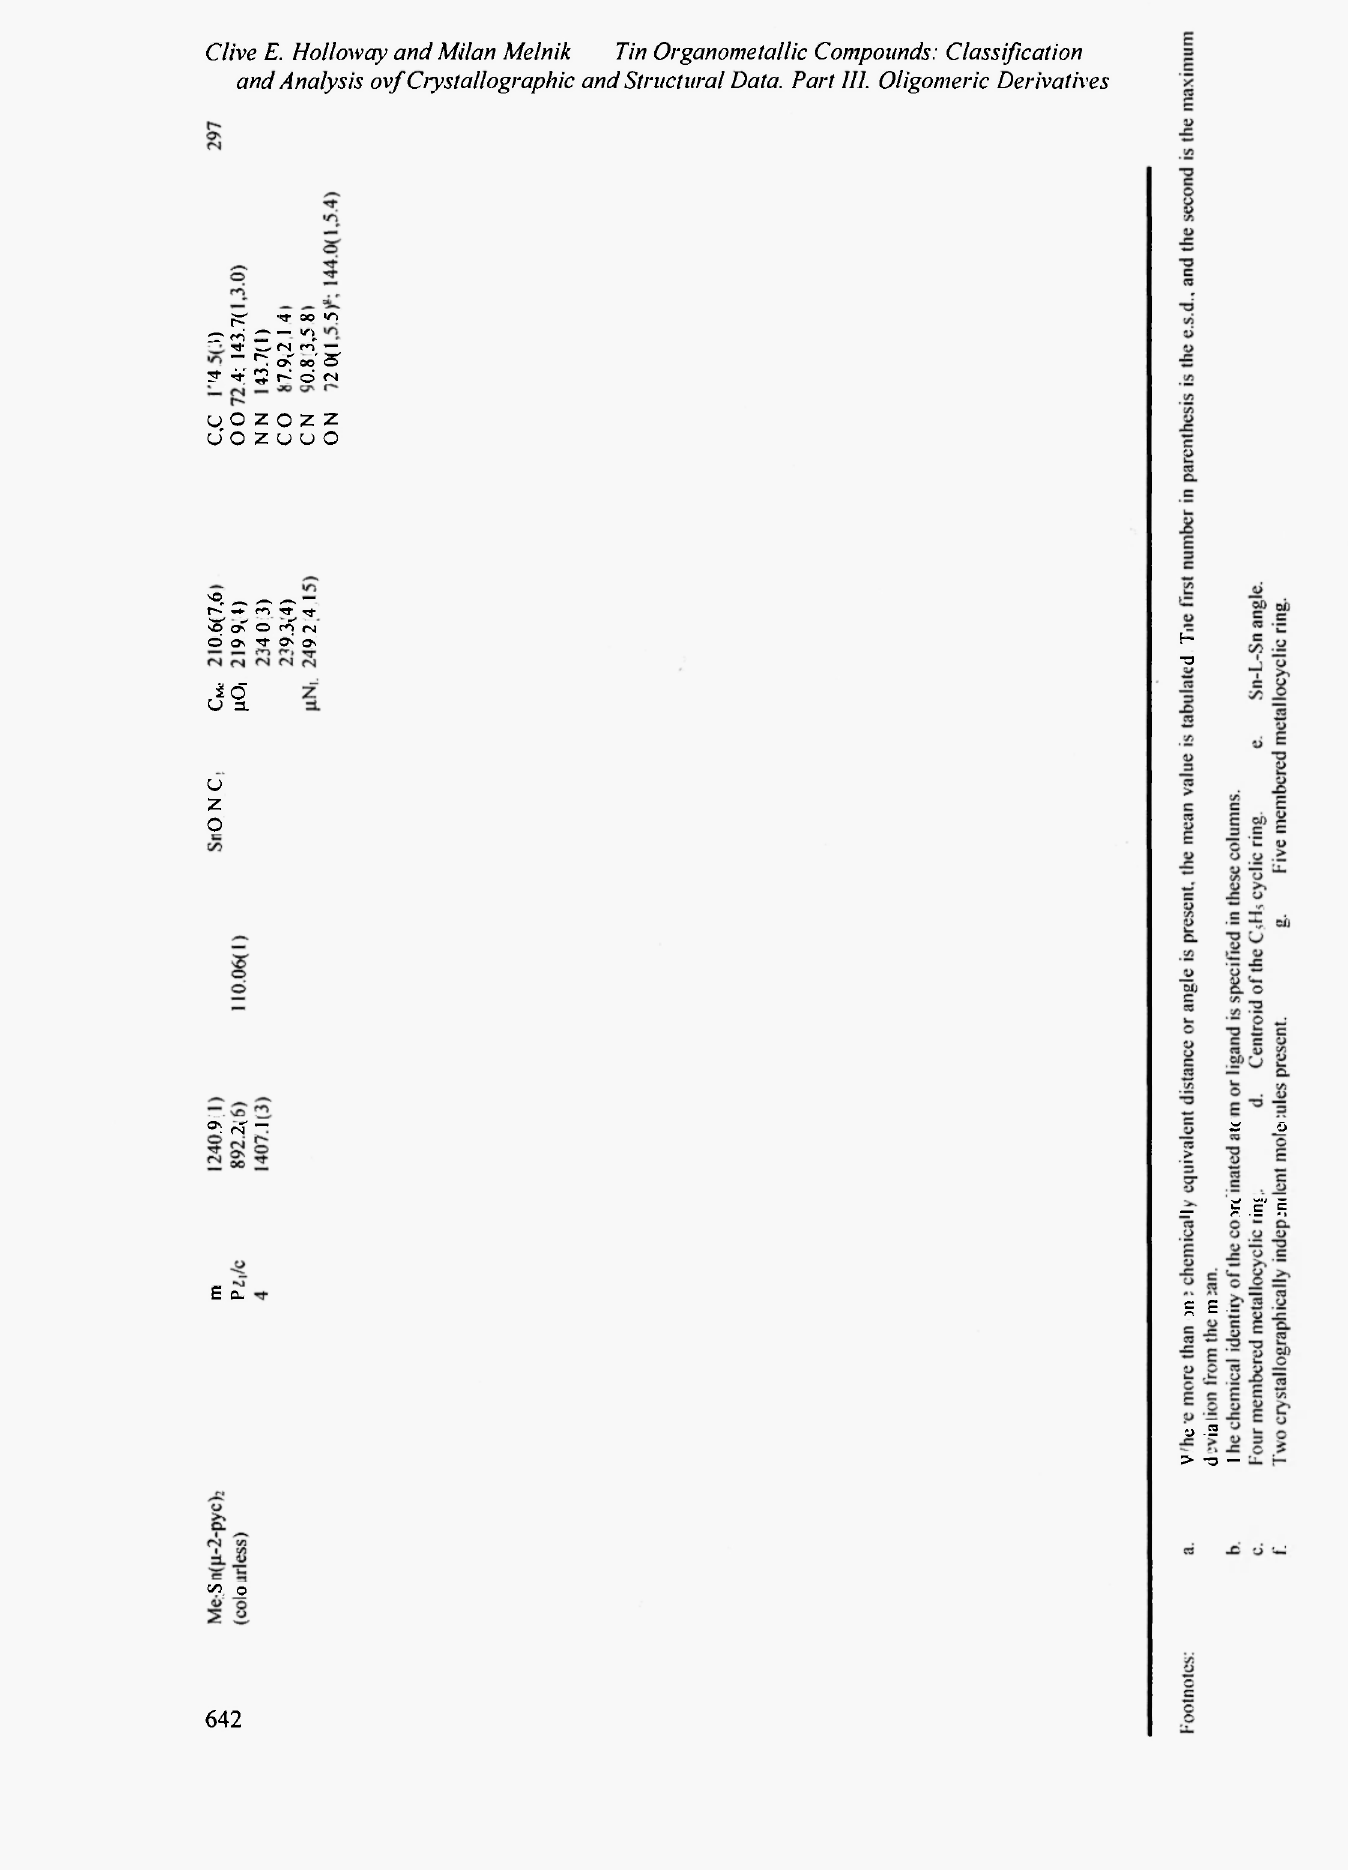
and Analysis ovf Ciystallographic and Structural Data. Part 111. Oligomeric